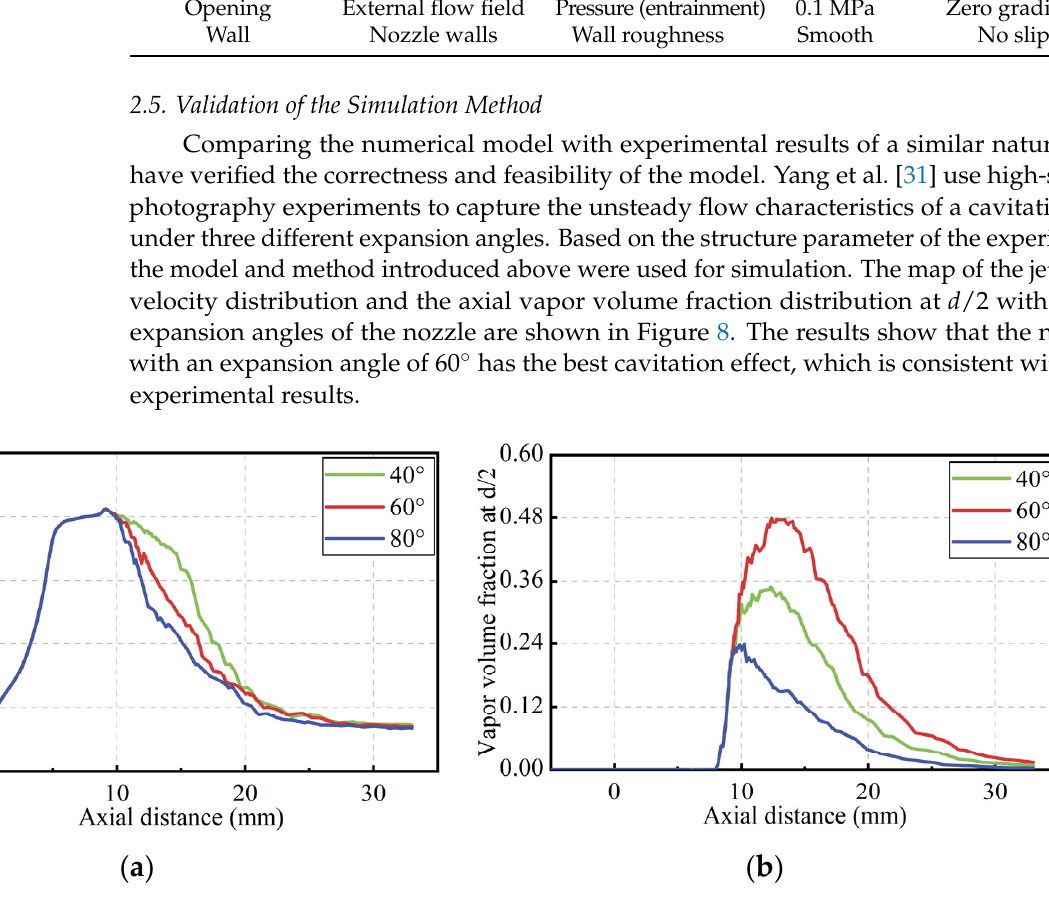
Figure 8. Effect of expansion angle on cavitation. ( a ) Axial velocity; ( b ) vapor volume fraction.